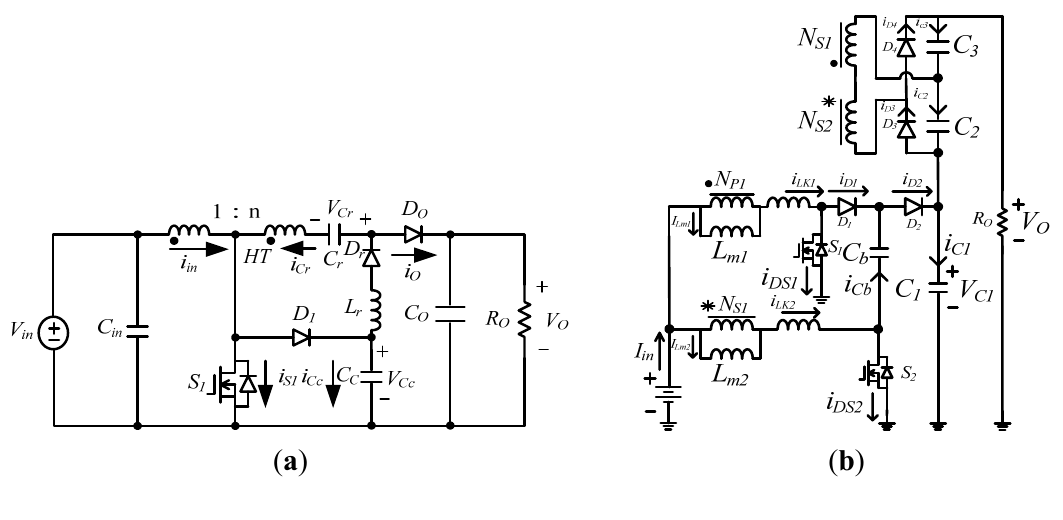
Figure 5. Schematic diagram of the conventional high step-up converters ( a ) proposed in [28]; and ( b ) proposed in [29].